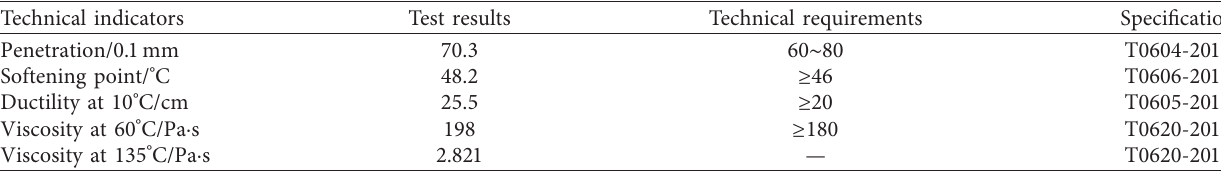
Table 1: Technical indicators of virgin asphalt 70#.